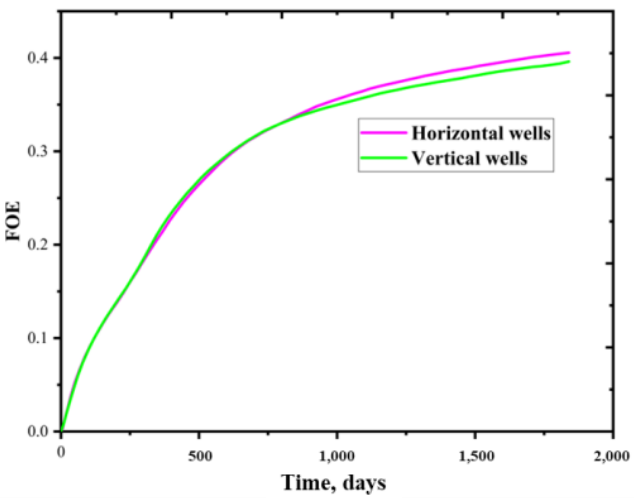
Figure 32. Field oil efficiency of vertical and horizontal wells against time.